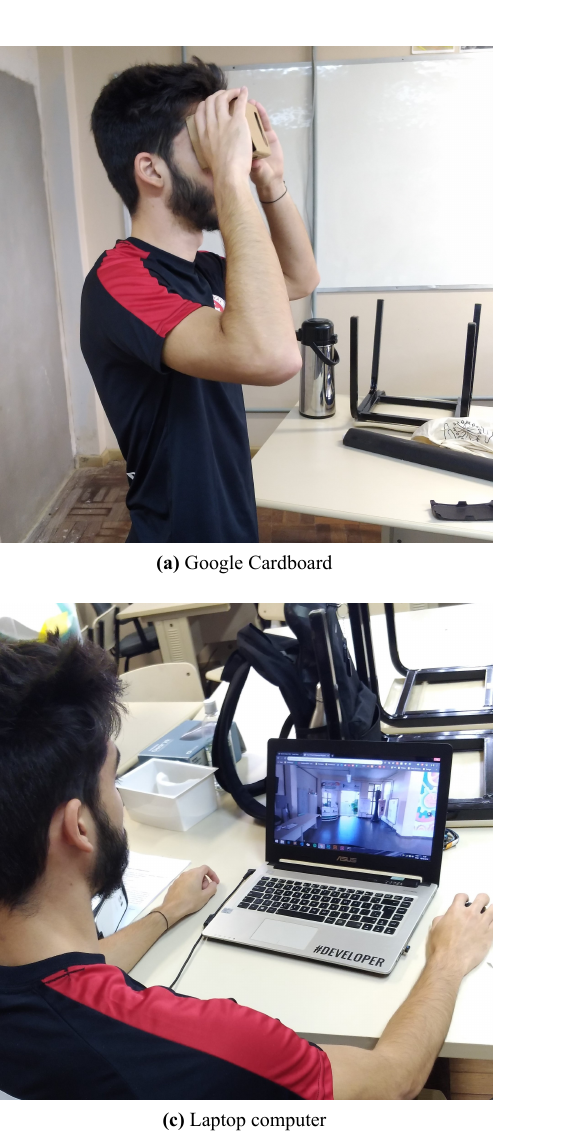
Figure 2. Use representation of each device operated by